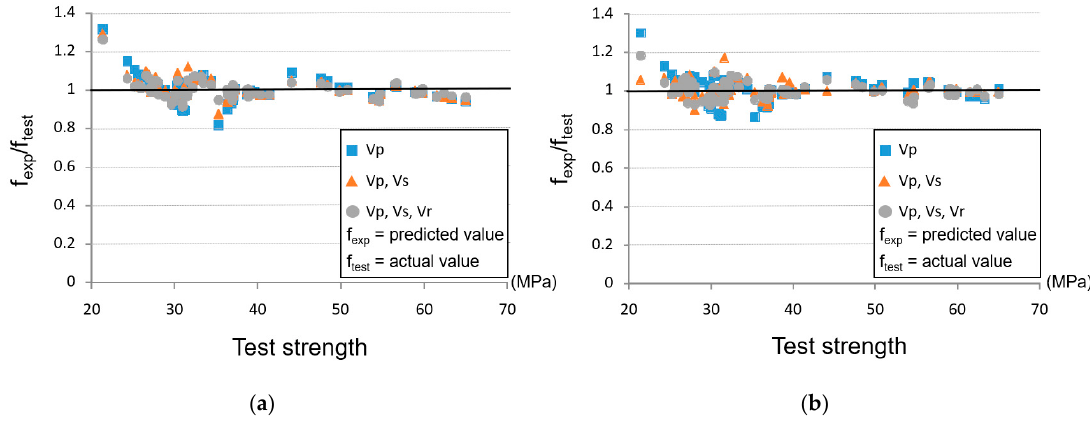
Figure 10. Distribution of predicted strength to test strength ratios. ( a ) SVM; ( b ) ANN.